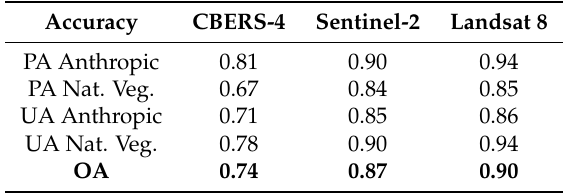
Table 2. Producer’s accuracy (PA), user’s accuracy (UA), and overall accuracy (OA) of the CBERS-4, Sentinel-2, and Landsat 8 data cube